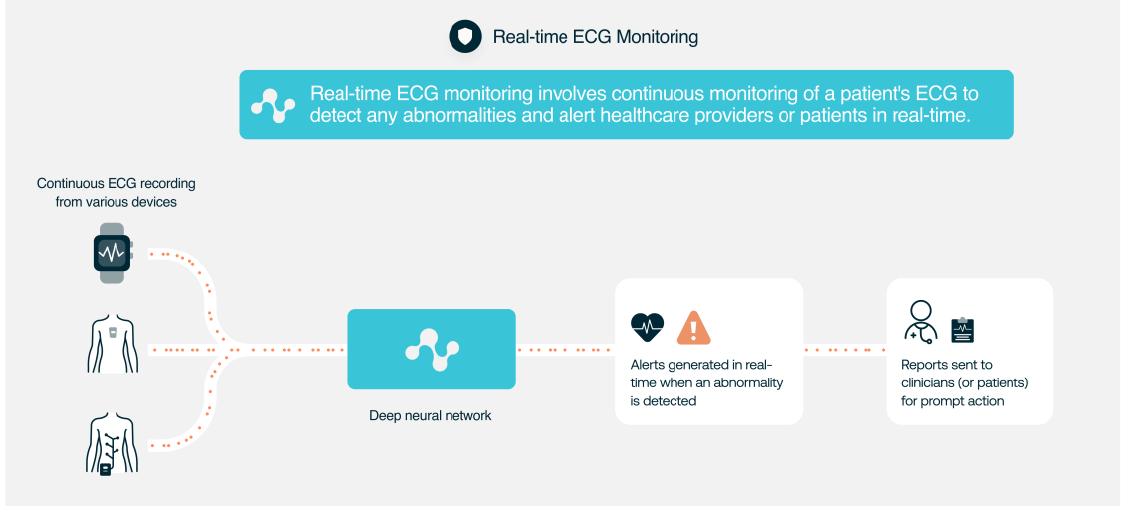
Figure 3. Use of AI ECG analysis for real-time ECG monitoring.